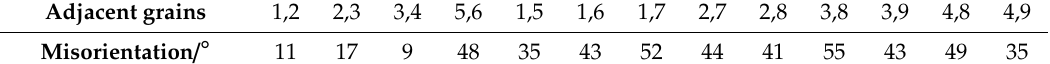
Figure 13. Stress transfer through low-angle misorientation grain boundaries, MPa. Table 3. Misorientations of adjacent grains in Figure 13.